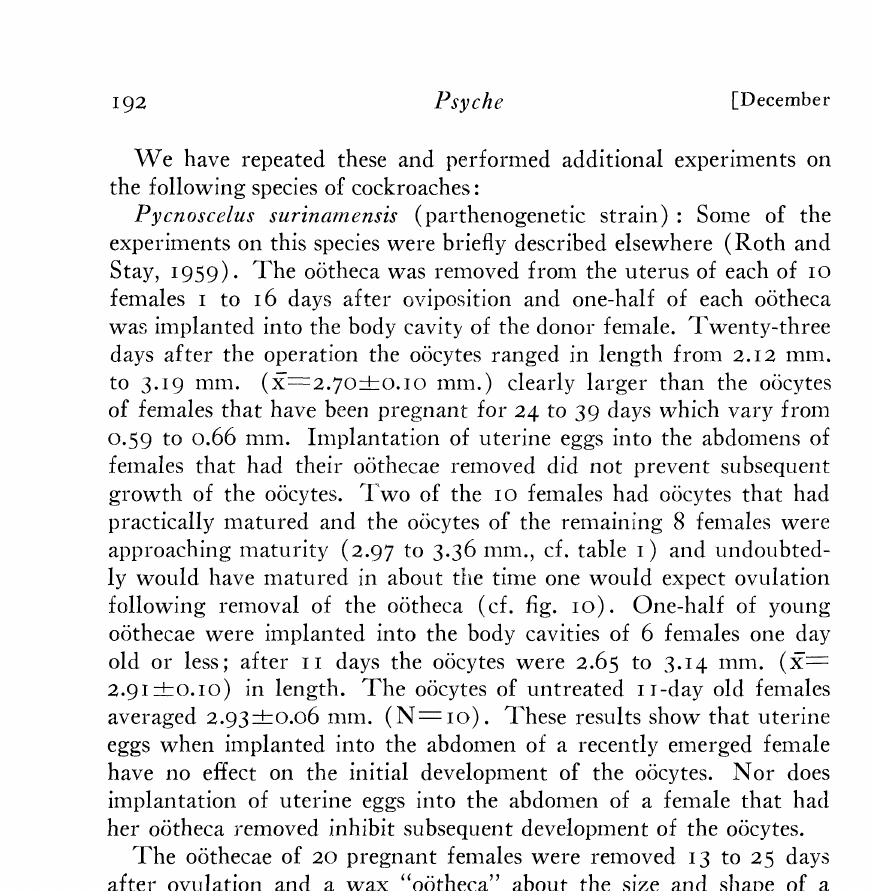
Fig. 12A. Pycnoscehts surinamensis (parthenogenetic strain). O6theca (upper) and ovaries (lower) of a female that had been pregnant 60 days and whose nerve cord was severed on the thirty-second day of pregnancy. When dissected 28 days after the operation, the embryos in the o6theea began to hatch. The o6eytes in the ovary had matured but were being resorbed. (Note the abundant eolleterial gland secretion [arrow]). Vertical line--3 mm. Fig. 12B, 12C. Blaberus craniifer. B. Mated female whose nerve cord was severed 26 days after oviposition. The o6theca (0) containing well developed embryos (note pigmented eyes) was being aborted 34 days after the operation. The o6eytes (arrow) were 5.88 mm. long. C. Virgin female that had carried an o6theea with undeveloped eggs for 93 days (well beyond the normal gesta- tion period). The o6eytes were 3.92 mm long. Vertical line=5